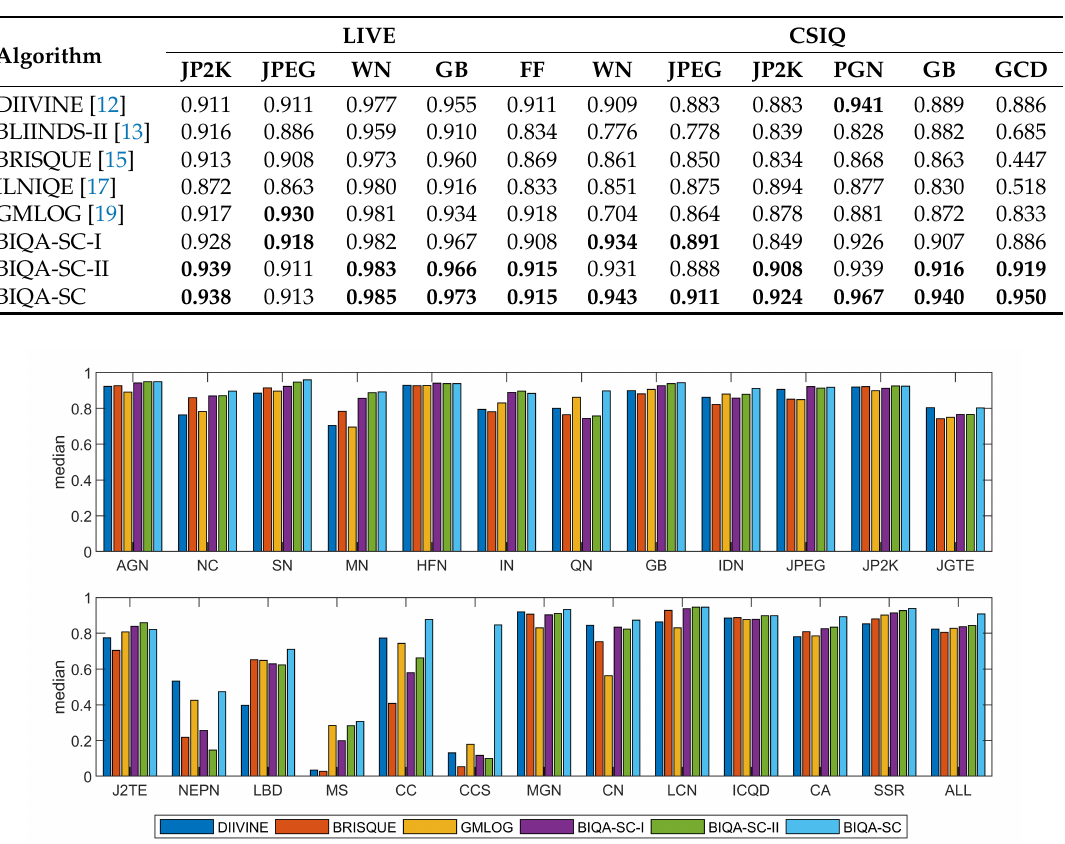
Figure 9. Median SROCC results of 1000 train-test trials on TID2013 database [39] for DIIVINE [12], BRISQUE [15], GMLOG [19], BIQA-SC-I, BIQA-SC-II and BIQA-SC. There are 24 distortion types in TID2013 [39] database, including additive Gaussian noise (AGN), additive noise in color components is more intensive than additive noise in the luminance component (NC), spatially correlated noise (SN), masked noise (MN), high frequency noise (HFN), impulse noise (IN), quantization noise (QN), Gaussian blur (GB), image denoising (IDN), JPEG compression (JPEG), JPEG2000 compression (JP2K), JPEG transmission errors (JPTE), JPEG2000 transmission errors (J2TE), non eccentricity pattern noise (NEPN), local block-wise distortions of different intensity (LBD), mean shift (MS), contrast change (CC), change of color saturation (CCS), multiplicative Gaussian noise (MGN), comfort noise (CN), lossy compression of noisy images (LCN), image color quantization with dither (ICQD), chromatic aberrations (CA), and sparse sampling and reconstruction